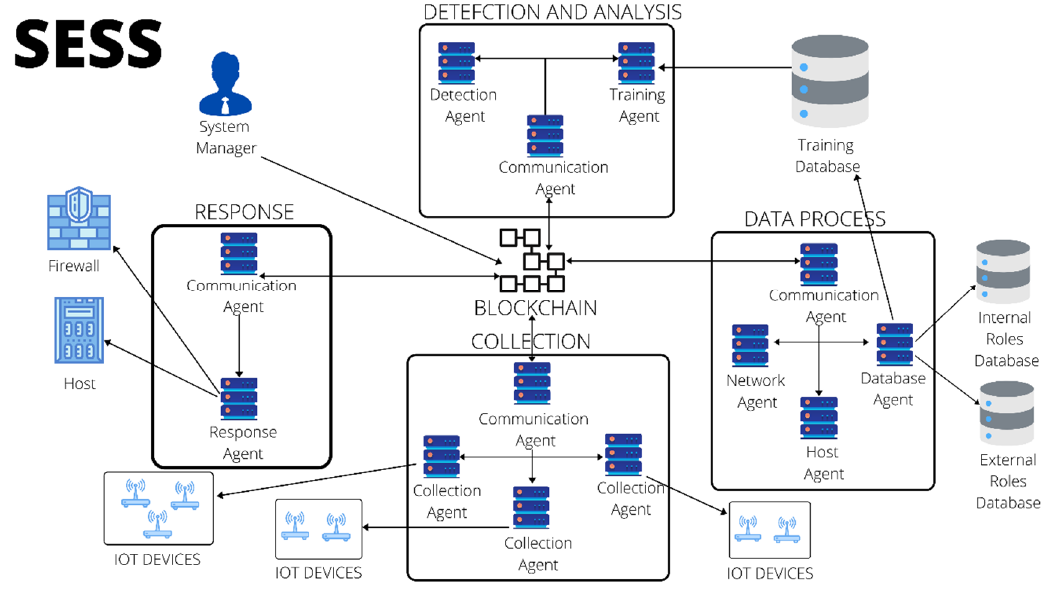
Figure 2. Intrusion detection system discussed [34].